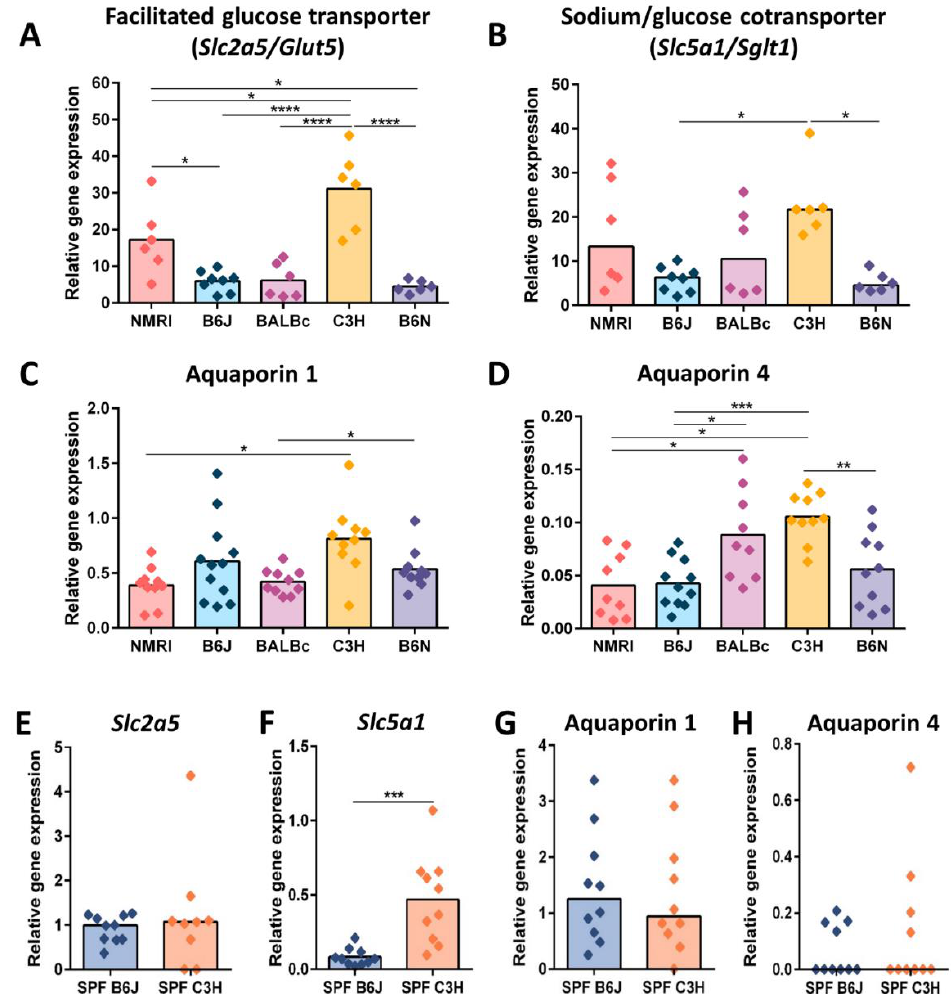
Figure 4. Involvement of water and electrolytes transport in cecal enlargement. ( A , B ) Gene expression of solute transporters: ( A ) Facilitated glucose transporter Slc2a5/Glut5 , and ( B ) Sodium/glucose cotransporter Slc5a1 / Sglt1 measured by qPCR in total RNA isolated from cecal tissue of five GF strains (NMRI, B6J, BALBc, C3H and B6N). Relative differences in gene expression were calculated by the comparative 2 − ∆∆ Ct method. Statistical differences for parametric data were calculated by one-way ANOVA with Tukey’s post-hoc test * p < 0.05, **** p < 0.0001. Box plot indicates mean (Slc2a5/Glut5). A Kruskal-Wallis test with Dunn ´ s multiple comparison test was used for the statistical analysis of nonparametric data * p < 0.05. Box plot indicates median ( Slc5a1 / Sglt1 ). Each symbol represents one independent sample. ( C , D ) Gene expression of aquaporins: ( C ) Aquaporin 1, and ( D ) Aquaporin 4 measured by qPCR in total RNA isolated from cecal tissue of five GF strains (NMRI, B6J, BALBc, C3H and B6N). Relative differences in gene expression were calculated by the comparative 2 − ∆∆ Ct method. The statistical analysis of parametric data was performed by a one-way ANOVA with a Tukey’s post-hoc test * p < 0.05, ** p < 0.01, *** p < 0.001. Box plot indicates mean. Each symbol represents one independent sample. ( E , F ) Gene expression of glucose transporters: ( E ) Facilitated glucose transporter Slc2a5 / Glut5 , and ( F ) Sodium/glucose cotransporter Slc5a1 / Sglt1 measured by qPCR in total RNA isolated from cecal tissue of complex microbiota colonized B6J and C3H mice. Statistical differences for parametric data were calculated with an unpaired t -test and for nonparametric data with a Mann-Whitney test, *** p < 0.001. The box plot indicates mean or median. Each symbol represents one independent sample ( G , H ) Gene expression of aquaporins: ( G ) Aquaporin 1, and ( H ) Aquaporin 4 measured by qPCR in total RNA isolated from cecal tissue of complex microbiota colonized B6J